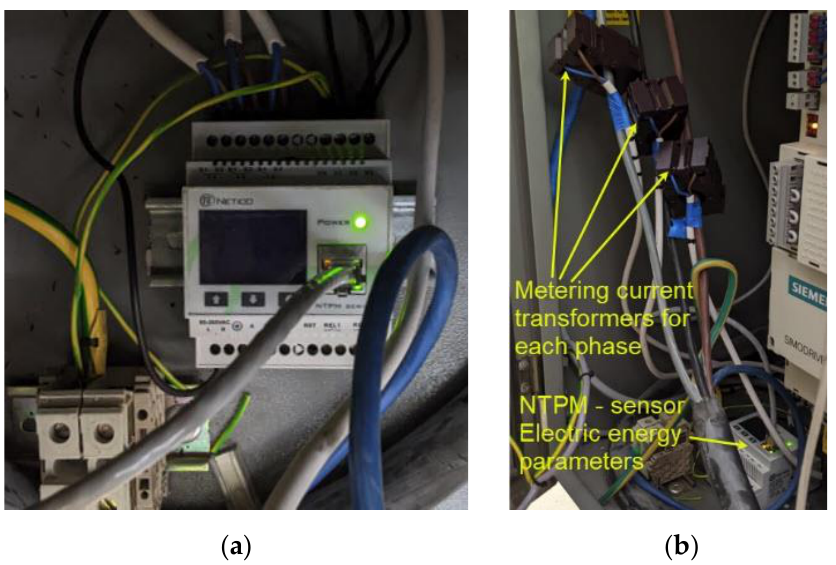
Figure 4. The current and voltage measurement setup: ( a ) installation of three metering current transformers and NTPM sensor in the energy cabinet of the CNC lathe. ( b ) NTPM sensor receives, processes and sends measured data through the ethernet.